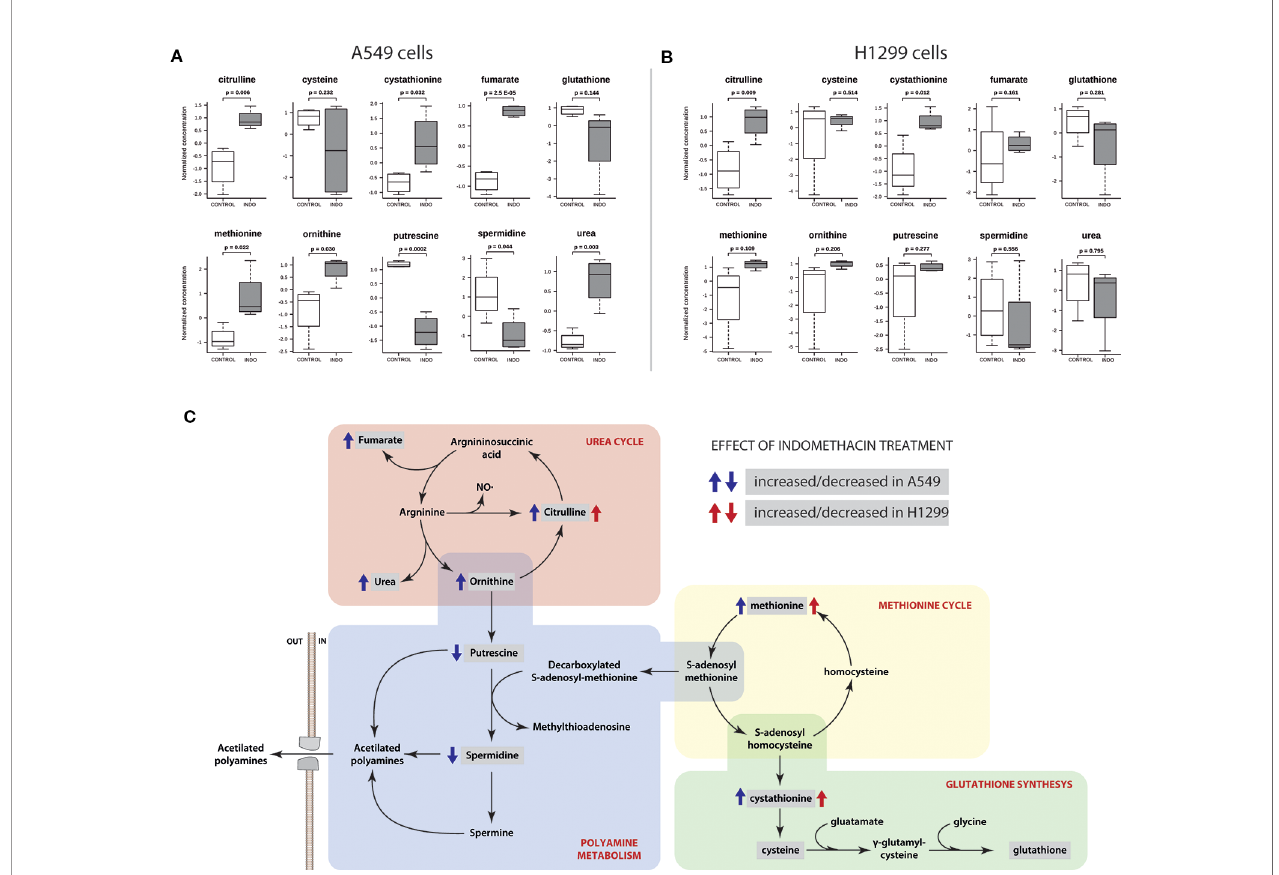
FIGURE 3 | Polyamine pathway-related metabolite pro fi ling of non-small cell lung cancer (NSCLC) cells exposed to indomethacin. A549 and H1299 cells were exposed to indomethacin for 24 h. An unbiased metabolomics analysis was performed using gas chromatography/mass spectrometry (GC/MS). Identi fi ed compounds were analyzed using the MetaboAnalyst platform. (A, B) Analyses of 10 selected metabolites after treatment with indomethacin in A549 (A) and H1299 (B) cells. The p values were calculated using the Student ’ s t-test between treated and untreated cells. (C) Pathway mapping showing the polyamine metabolism and related pathways. Identi fi ed metabolites are enclosed in gray boxes. Blue and red arrows indicate the change (i.e., increase or decrease) of each metabolite in A549 or H1299 cells after exposure to indomethacin. Data summarize the results of four independent